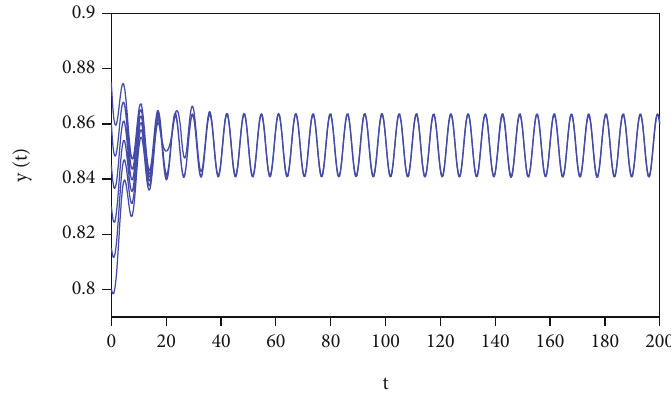
Figure 1: Dynamics of system (55). Here, we take di ff erent initial